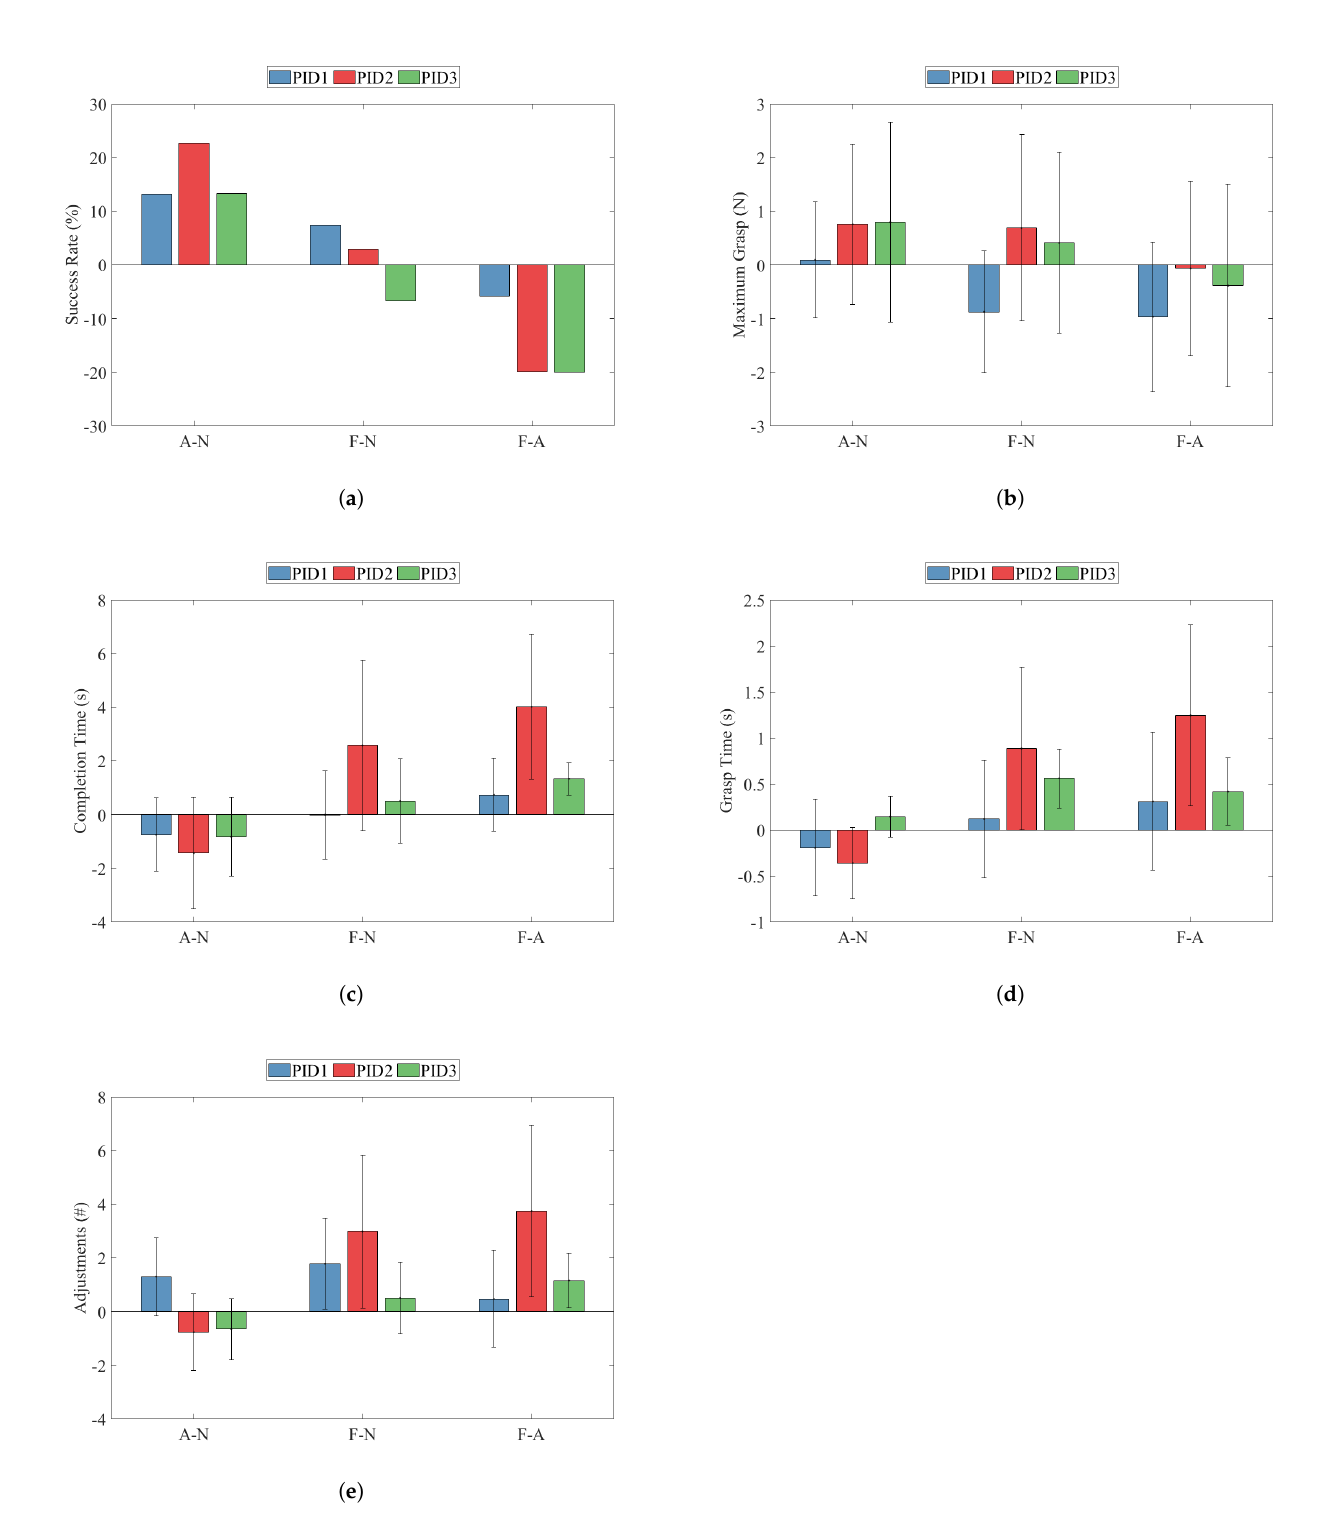
Figure 10. Within-participant results for ( a ) success rate, ( b ) maximum grasp, ( c ) completion time, ( d ) grasp time, ( e )